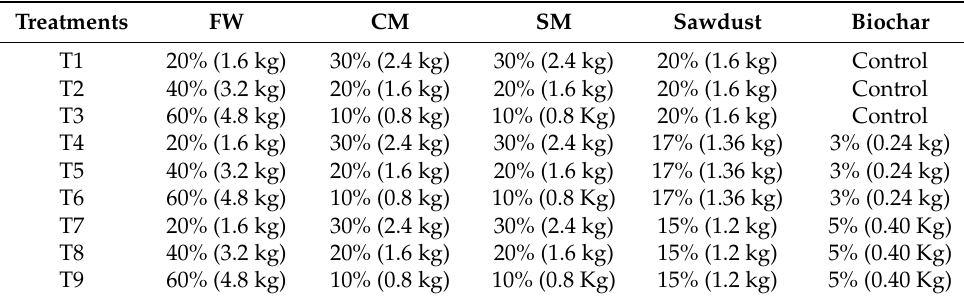
Table 1. Weight proportions of